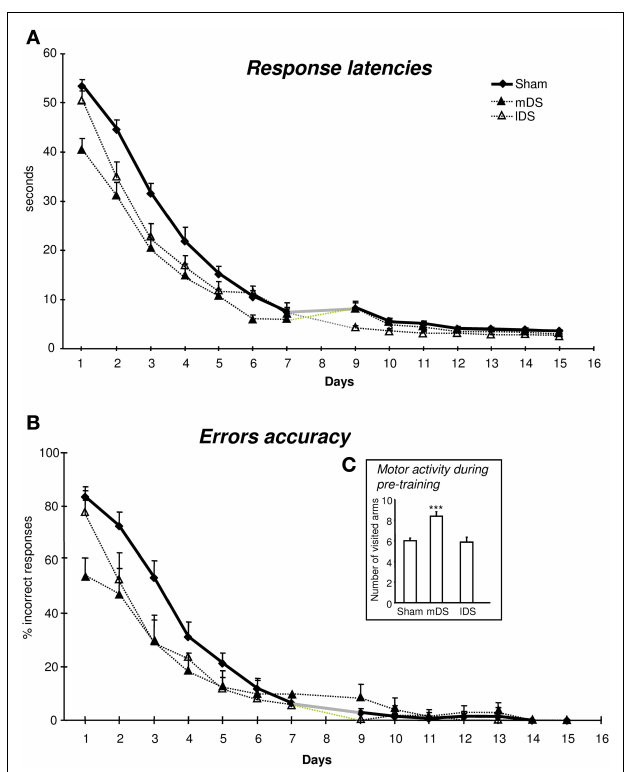
FIGURE 1 | Reconstruction of mDS (A) and lDS (B) lesions at different rostrocaudal levels ( + 2.2 to − 0.8 mm from bregma). Black area, region lesioned for 75–100% of the rats; grey area, region lesioned for 50–75% of the rats; dotted area, region lesioned for 25–50% of the rats. Nomenclature is